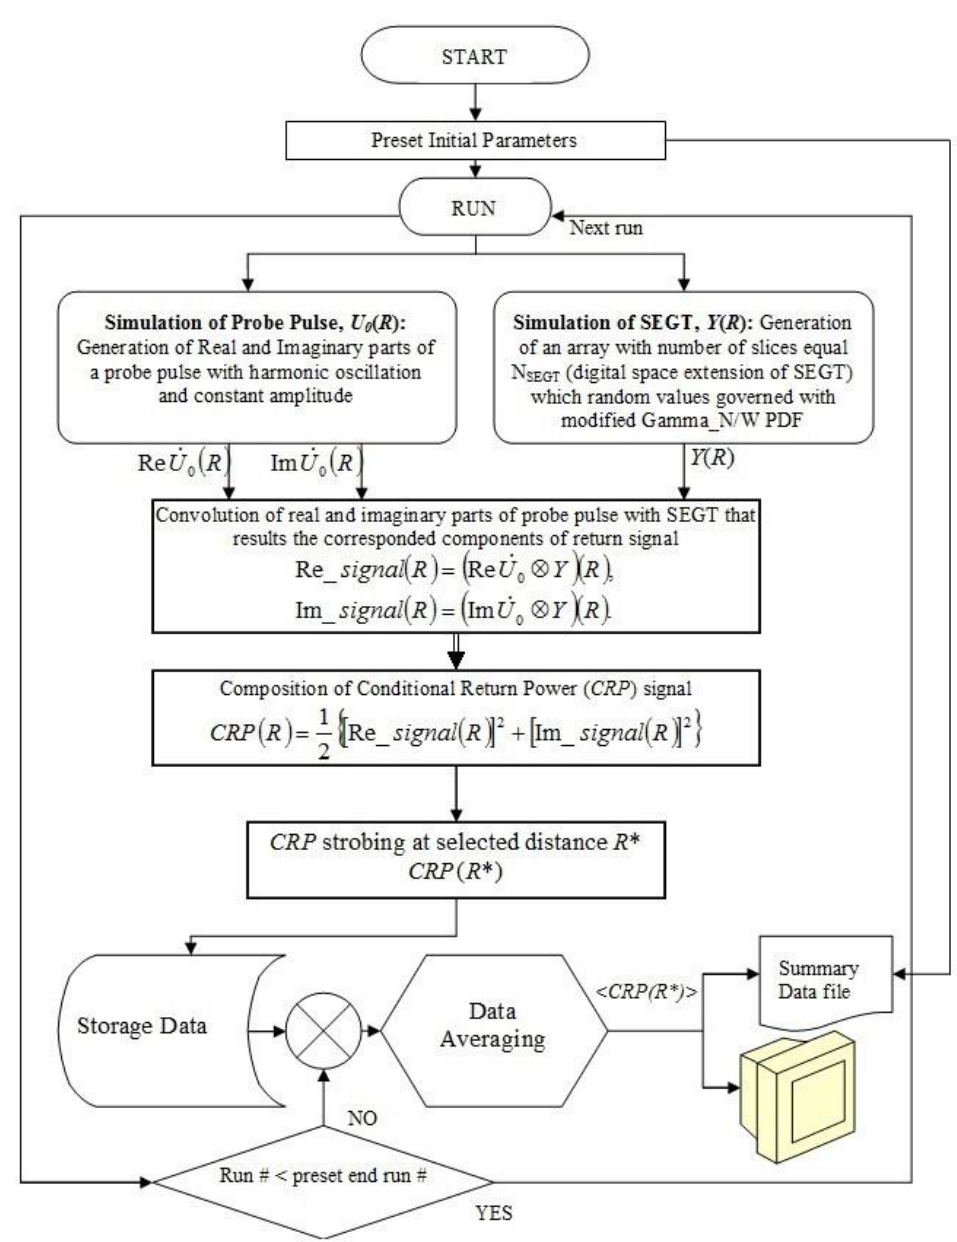
Figure 1. Flowchart of the simulation procedure .